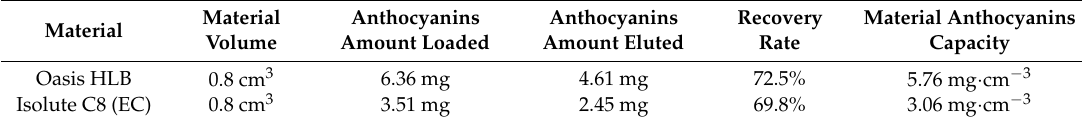
Table 6. Determination of anthocyanins capacity of Oasis HLB and Isolute C8 (EC) materials.